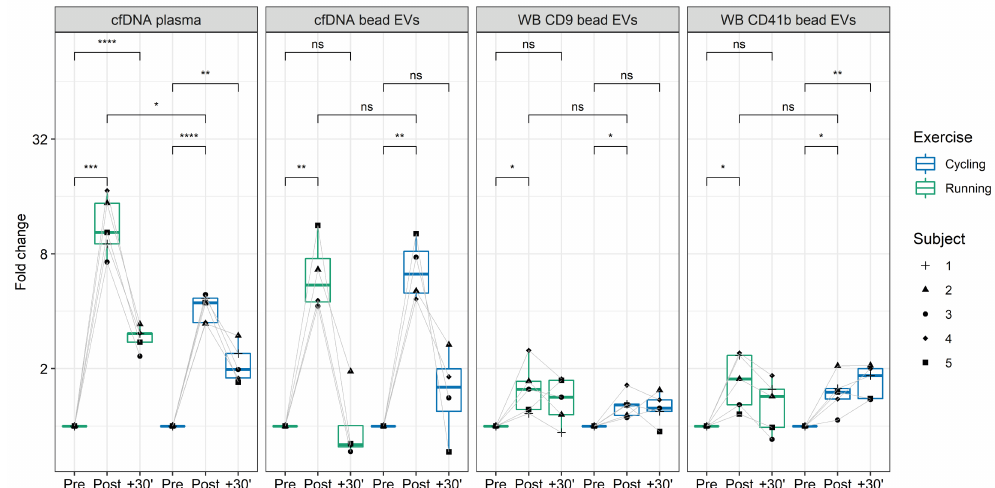
Figure 4. cfDNA and CD9 + /CD63 + /CD81 + EVs kinetics in running versus cycling. The fold-changes of plasma cfDNA and CD9 + /CD63 + /CD81 + EVs DNA, detected with qPCR, and fold changes of CD9 + /CD63 + /CD81 + EVs, represented by CD9 and CD41b Western blot analysis, in running and cycling exercise are illustrated. The labels represent selected comparisons between time points and exercise modalities, reflecting unadjusted p-values (* = p < 0.05, ** = p < 0.01, *** = p < 0.001, **** = p < 0.0001). ns: not